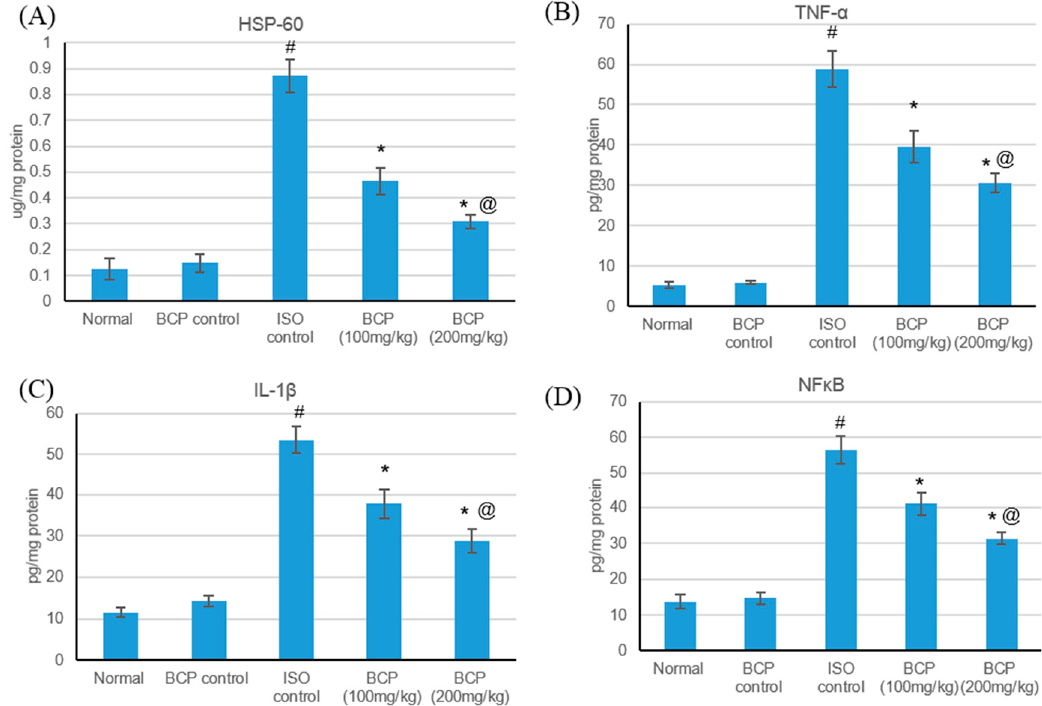
Figure 8. E ff ects of β -caryophyllene treatment (100, 200 mg / kg) for 21 days on HSP-60 and inflammatory markers in ISO-induced myocardial infarction: ( A ) HSP-60, ( B ) TNF- α , ( C ) IL-1 β , and ( D ) NF- κ B. All values were expressed as mean ± SD ( n = 6). ISO: isoproterenol; BCP: β -Caryophyllene; HSP-60: Heat shock protein 60; TNF- α : Tumor necrosis factor–alpha; IL-I β : Interleukin-1 β and NF κ B: nuclear factor- κ B. # indicates statistically significant from normal group, * indicates statistically significant from isoproterenol group, @ indicates statistically significant from the β -caryophyllene (100 mg / kg) group ( p < 0.05) using one-way ANOVA followed by Tukey’s test as a post-hoc analysis.